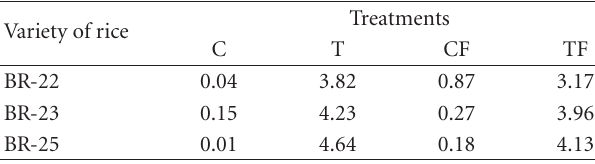
Table 9: As (mg kg − 1 ) in the soils after harvest of the aman rice. Variety of rice